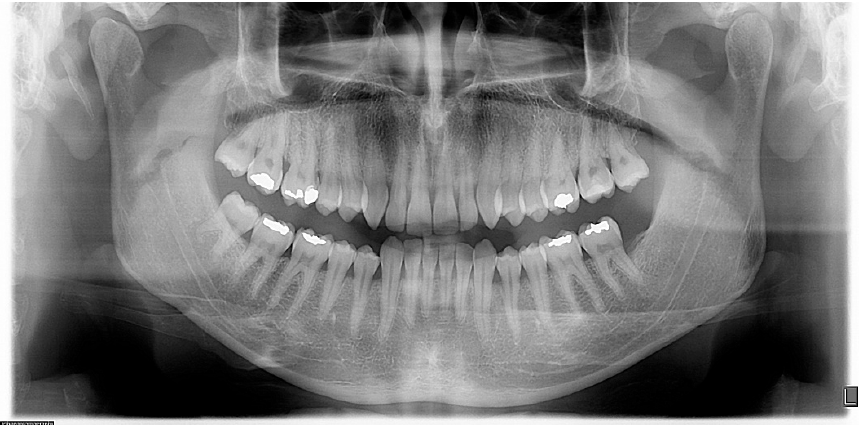
Figure 7. Panoramic radiography carried out perfectly. The dark space between the two dental arches represented by the occlusal plane shows a mild upper concavity, since the Frankfort and occlusal planes tend to converge posteriorly.